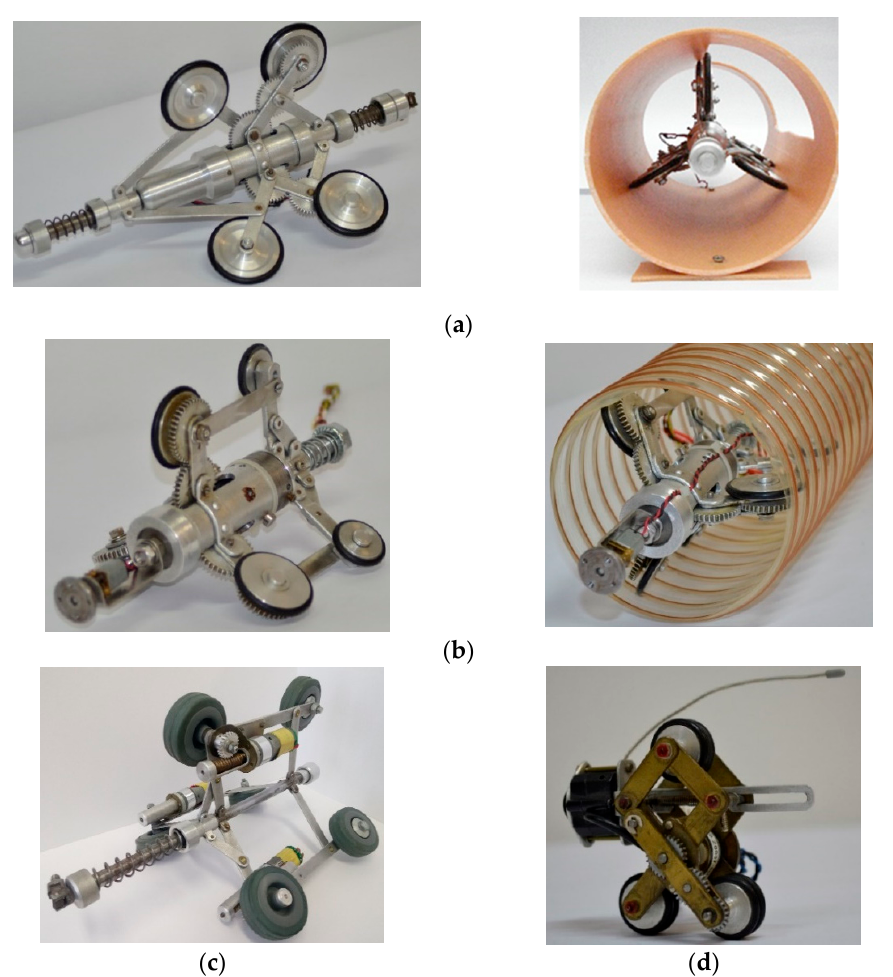
Figure 3. Prototypes of wall pressed robots designed and manufactured by authors. ( a ) Prototype based on slider-crank linkage; ( b ) prototype based on a combined linkage; ( c ) prototype based on a combined linkage with three gearmotors; and ( d ) prototype based on a pantograph linkage.